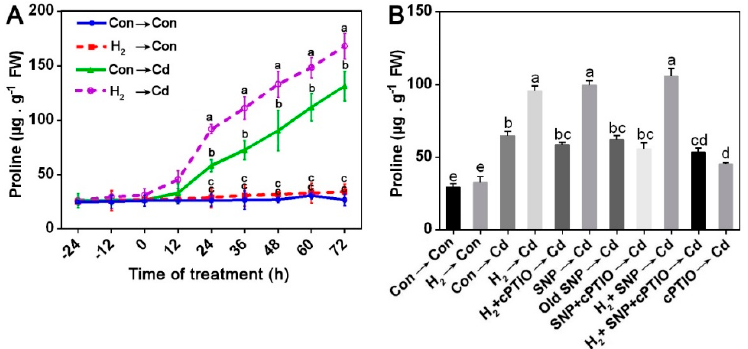
Figure 7. Time course of proline content under H 2 treatment and its sensitivity to NO scavenging. Two − day − old mycelia were either pre-treated or not with 3% H 2 for 24 h and then were stressed or not for 72 h. Then, proline was quantified at the indicated time points ( A ). Additionally, as shown in B, two − day − old mycelia were either pre-treated or not with H 2 for 24 h and then were stressed or not for 24 h. Stressed mycelia were either subjected or not to 500 μ M SNP, 500 μ M old SNP, or 500 μ M cPTIO alone or in the indicated combinations for 30 min after H 2 treatment. Afterward, proline was measured ( B ). Different letters indicate significant differences between treatments at the indicated time points in A or after 24 h in B according to one-way ANOVA with multiple comparison using Tukey’s test at p < 0.05.